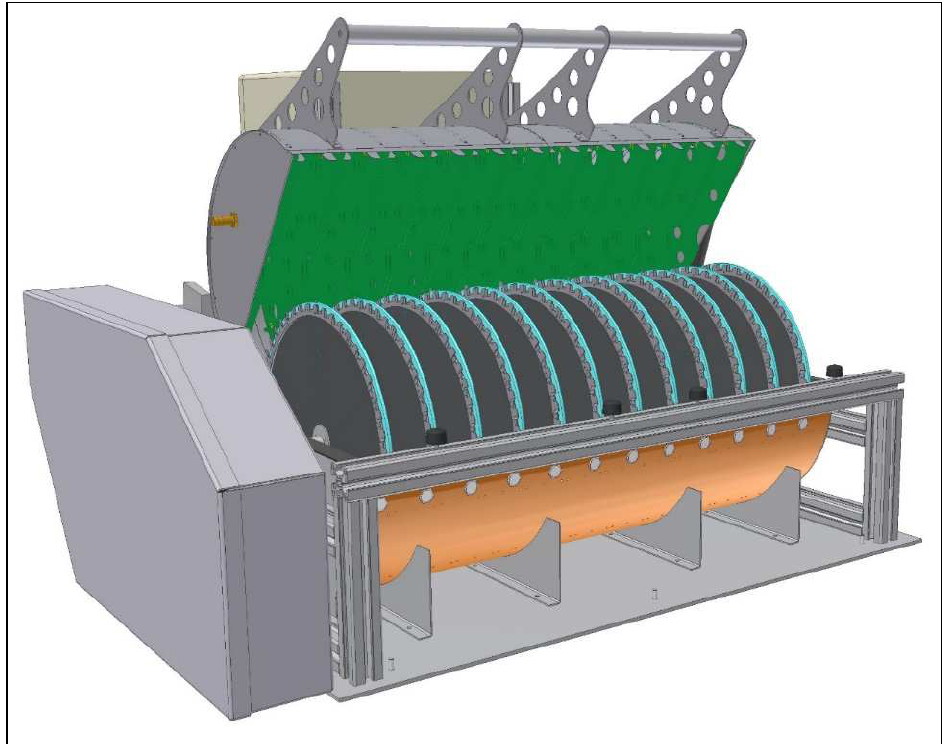
Figure 3. Schematic 3D-Model of the photocatalytic immersion body reactor (© Lynatox GmbH, 2020).